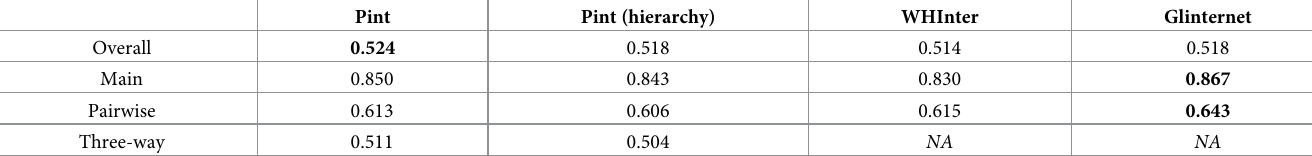
Table 3. AUROC for simulated three-way interaction data sets, separated by the type of effect.